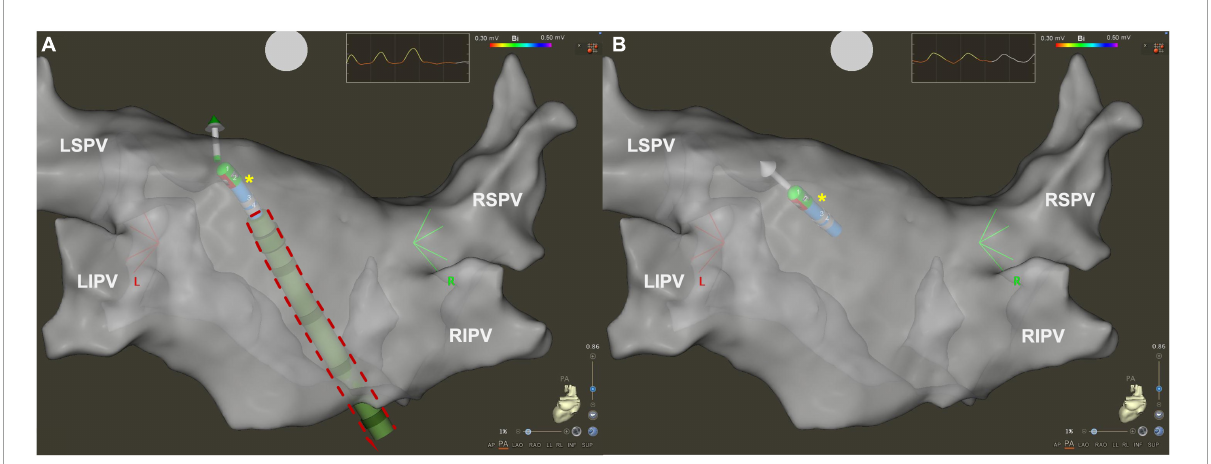
FIGURE1 Three dimensional electroanatomical map of left atrium in posteroanterior view visualized by CARTO3 system. (A) Using visualizable steerable sheath (red dashed line), it is easier to understand spatial relationship between the ablation catheter (yellow asterisk) and the sheath. (B) Using standard steerable sheath, only the ablation catheter is visualized by the CARTO3 system. LIPV, left inferior pulmonary vein; LSPV, left superior pulmonary vein; RIPV, right inferior pulmonary vein; RSPV, right superior pulmonary